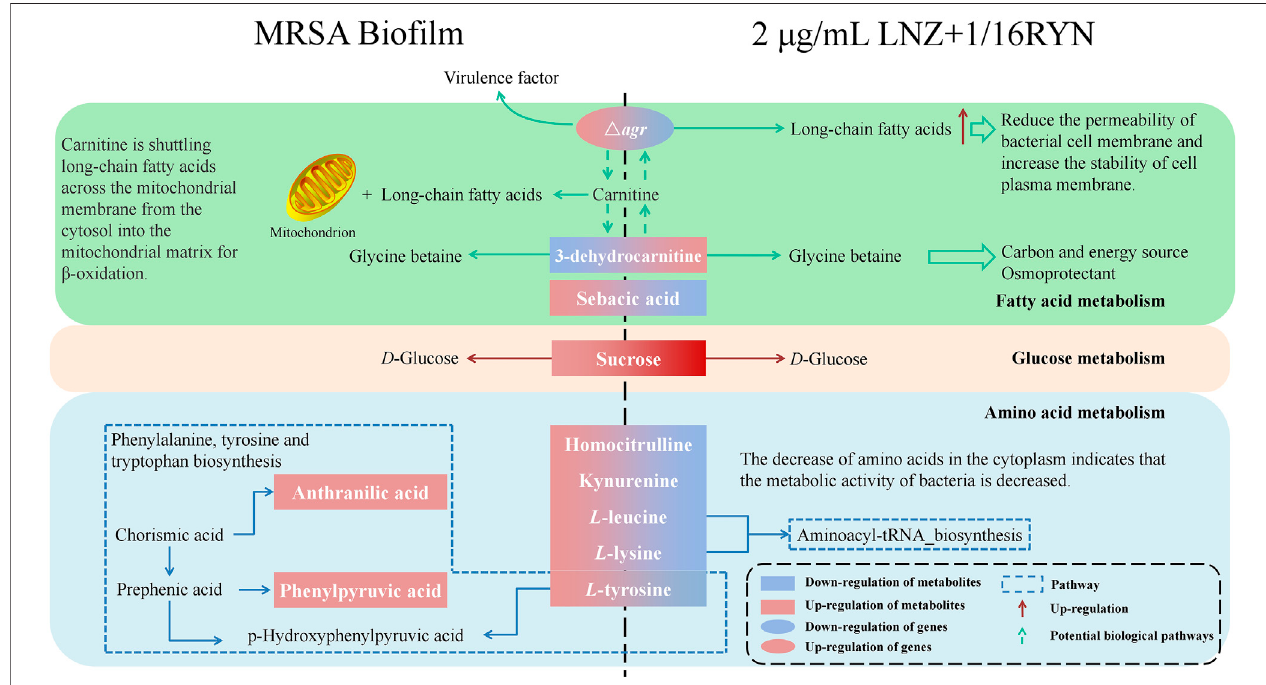
FIGURE 8 | Effects of RYN combined with LNZ on MRSA metabolites. Boxes are differential metabolites and oval boxes are genes. Red boxes and red arrows indicate upregulation, and blue boxes indicate downregulation. Dashed boxes indicate pathways. Dashed arrows indicate possible potential biological pathways.